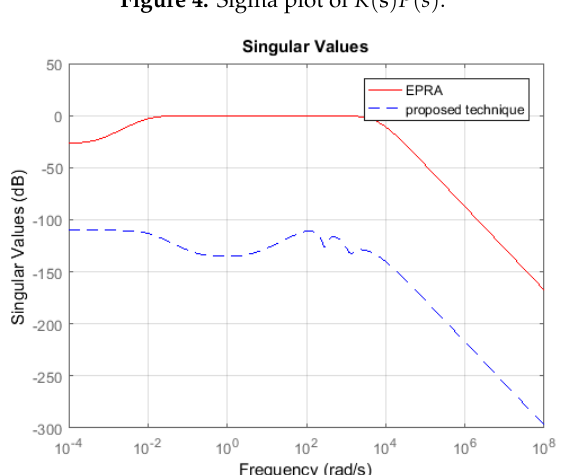
Figure 4. Sigma plot of 𝐾(s)𝑃(𝑠).